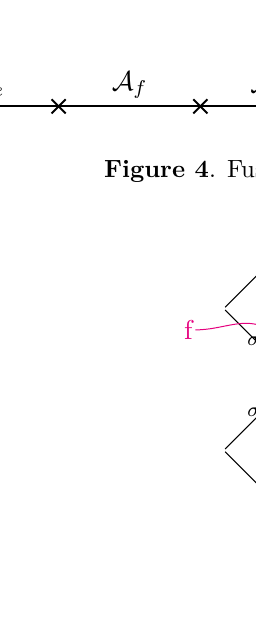
Figure 5 . Both the Kitaev model [35] and the Wen Plaquette model [50] realize the toric code topological order. They are illustrated in the same picture here. The black lines denote the lattice of Kitaev’s toric code model and the blue lines denote the lattice of the Wen plaquette model [50]. Note that in the former, the spin-degrees of freedom lives on the links, whereas in the latter, they live on the vertices. Therefore, where the black lines intersect the blue lattice lives a spin 1/2 degree of freedom. The plaquettes are divided into two sets, the Z and X plaquettes. The Hamiltonian acts in a way depending on this division, as reviewed briefly in